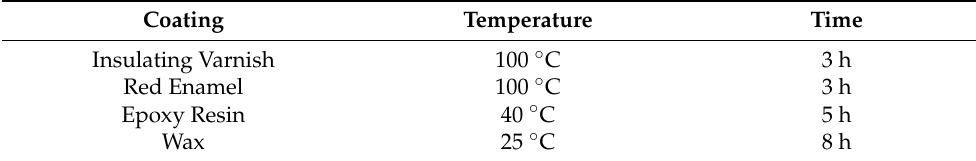
Table 5. Curing conditions for all coatings.